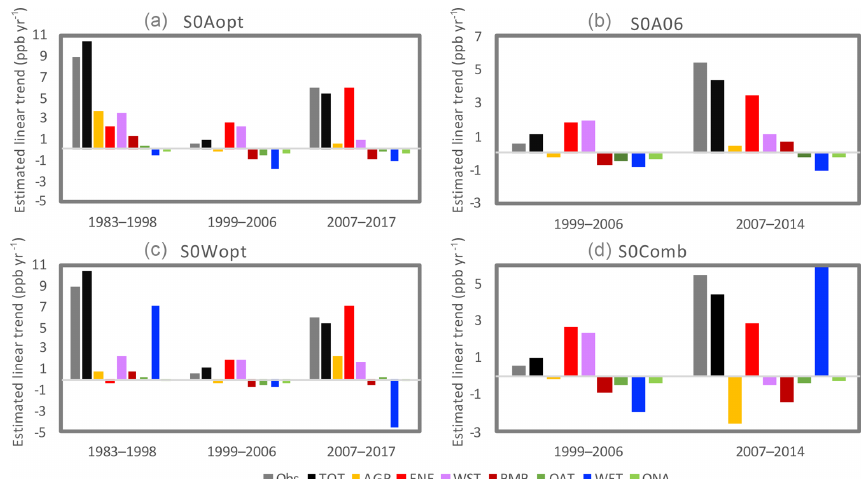
Figure 7. Estimated global linear trends for source-tagged tracers and total methane (TOT). The source-tagged tracers include tracers for the agriculture sector (AGR), energy sector, (ENE), waste sector (WST), biomass burning sector (BMB), other anthropogenic sectors (OAT), wetland sector (WET), and other natural sectors (ONA). The grey bar represents the total methane trend from NOAA GMD observations. In panels (a) and (c) (i.e., S0Aopt and S0Wopt), the trends are estimated for the periods of 1983–1998, 1999–2006, and 2007–2017. In panels (b) and (d) (i.e., S0A06 and S0Comb), the trends are estimated for the period of 2007–2014, with 1999–2006 trends from S0Wopt and